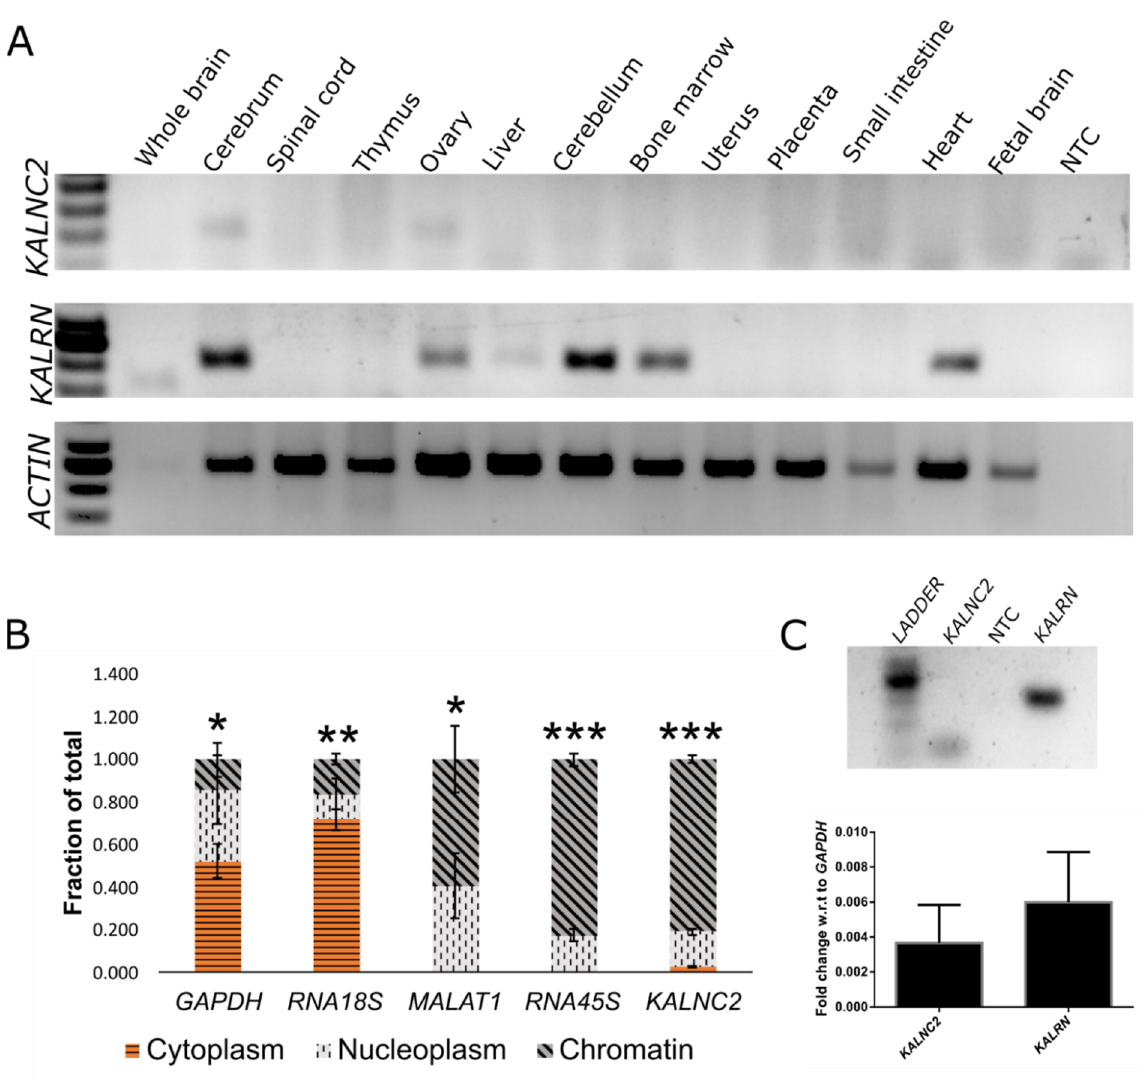
Figure 6. hsKALNC2 is exclusively expressed in brain tissues. ( A ) Expression of KALNC2 (119 bp) and KALRN (238 bp) in human tissue RNA panel, available commercially ( B ) Subcellular fractionation of SH-SY5Y cells using RNA18S, MALAT1 , and RNA45S as cytoplasmic, nucleoplasmic, and chromatin markers, respectively. ( C ) Expression of KALNC2 and KALRN in SH-SY5Y cells normalized to GAPDH expression. (Data are shown as mean ± SD; N = 3 biological replicates; n = 3 technical replicates; t -test, * p < 0.05; ** p < 0.01; *** p <